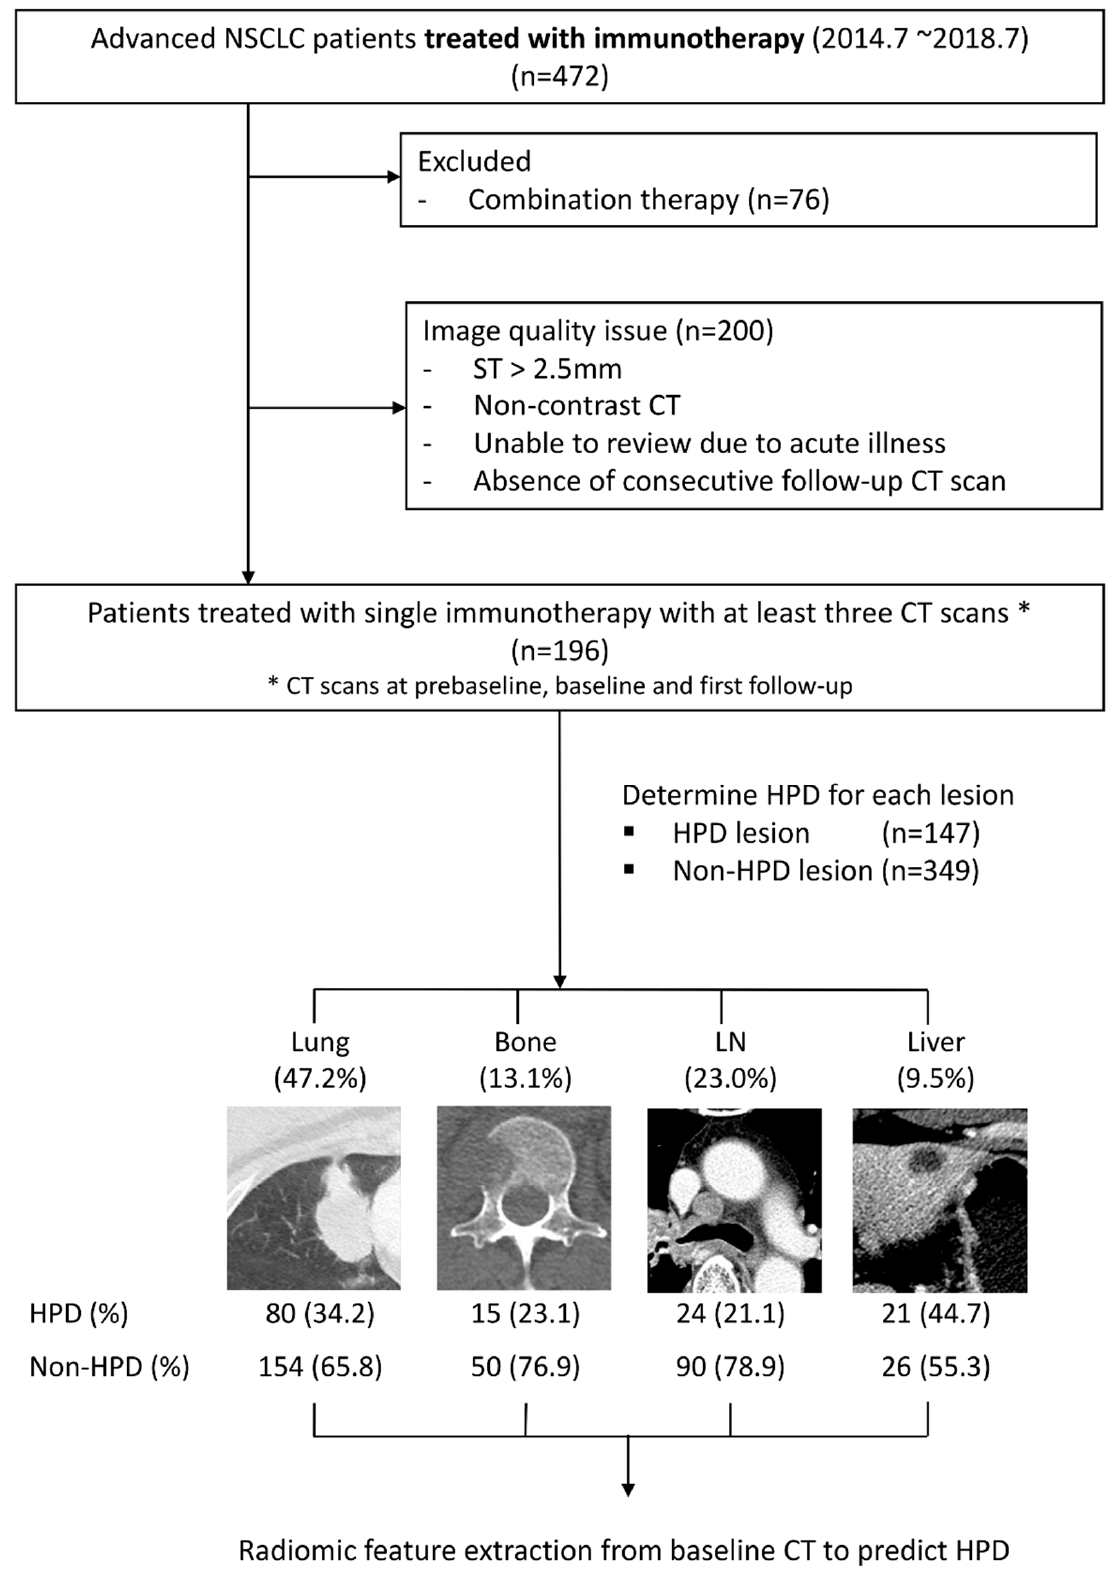
Figure 1. Flowchart of patient enrollment, exclusion, and our lesion-based radiomics approach. HPD, hyperprogressive disease; LN, lymph node; NSCLC, non-small cell lung cancer; ST, slice thickness.